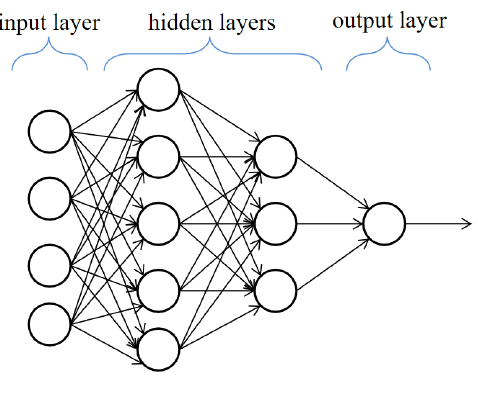
Fig. 1 An example of MLP.